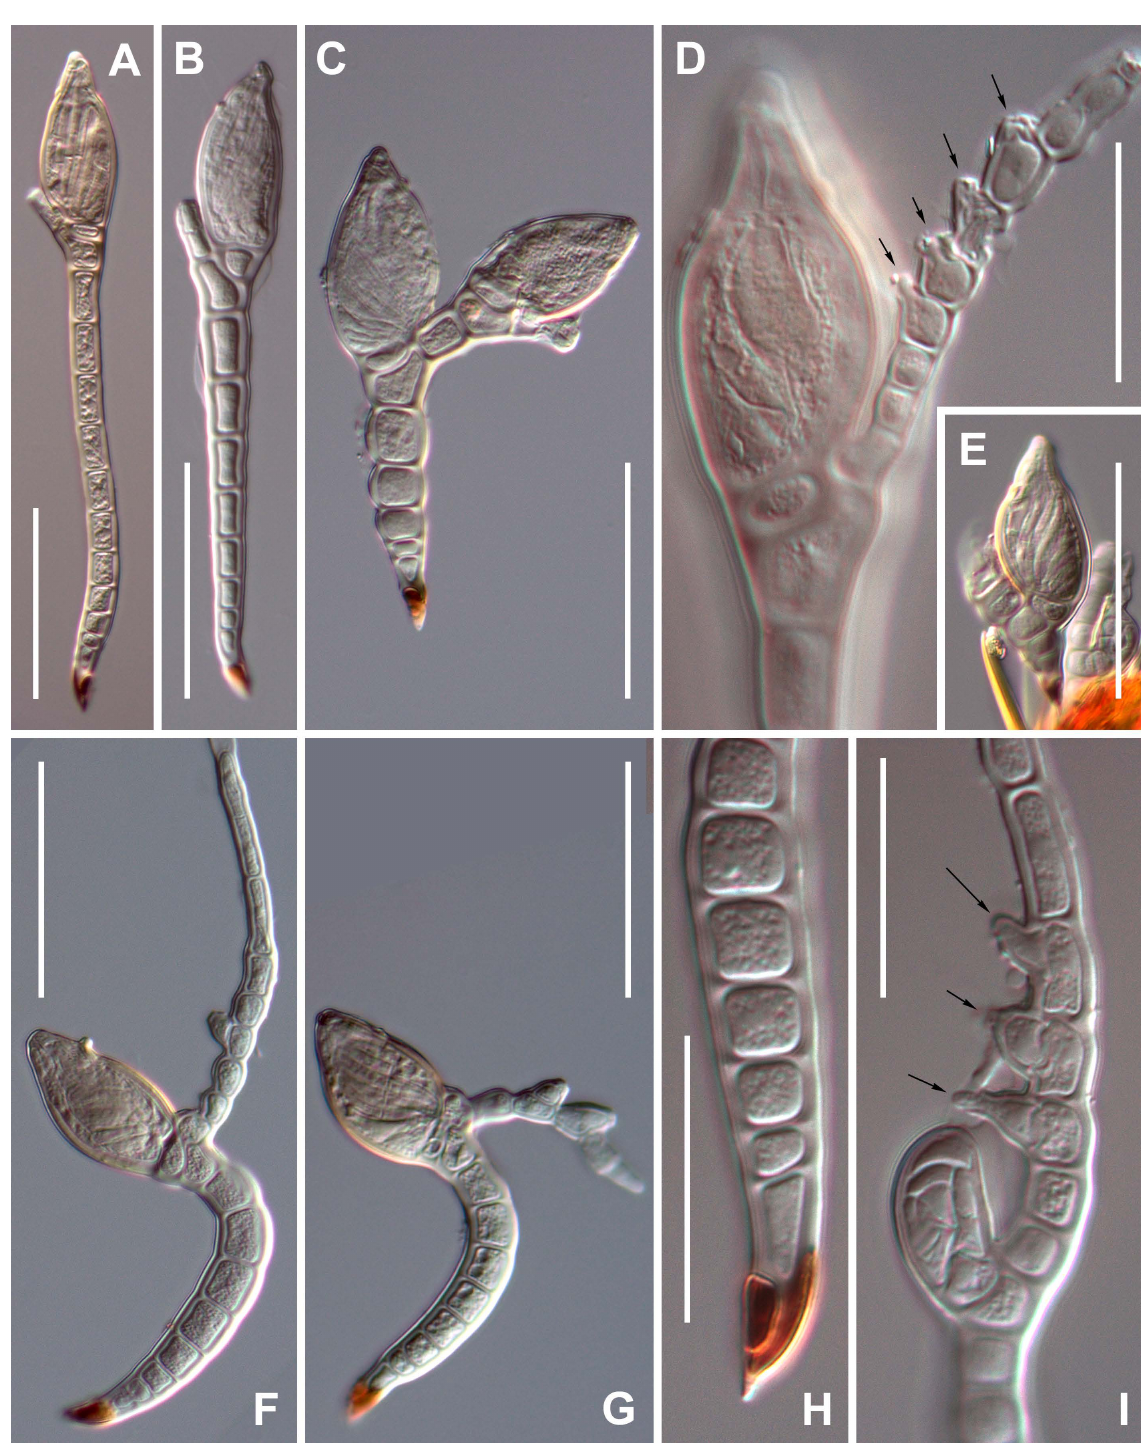
Fig. 12. Siemaszkoa spp. A – E . S. fennica Huldén. A – B . Mature thalli. C . Unusual thallus with two perithecia. D . Detail of a mature thallus showing antheridia (arrows). E . Short thallus from legs. – F – I . S. flexa (T.Majewski) I.I.Tav. & T.Majewski. F – G . Mature thalli. H . Detail of foot. I . Detail of an immature thallus showing antheridia (arrows). Scale bars: A–C, E–G = 50 µm; D, H–I = 20 µm. Photographs from slides ZMUC C-F-122949 (A), ZMUC C-F-123248 (B), ZMUC C-F-123466 (C), ZMUC C-F-123309 (D), ZMUC C-F-123582 (E), ZMUC C-F-123632 (F–G), ZMUC C-F-123583